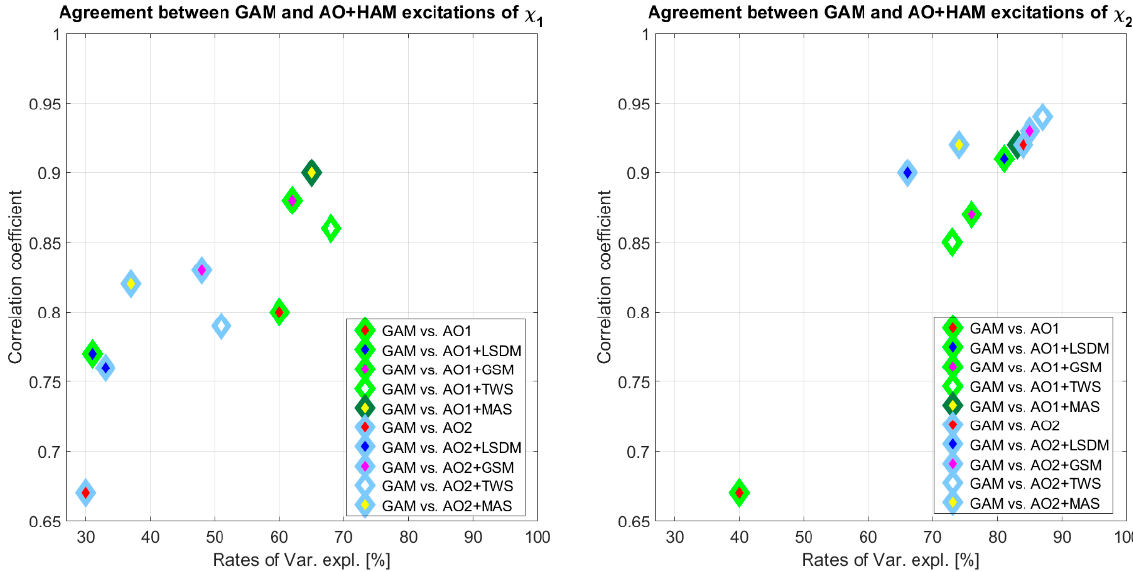
Figure 6. Correlation coefficients and variance explained rates between geodetic and geophysical interannual PM excitations improved by different HAM excitations, for χ 1 ( left panel ), and χ 2 ( right panel ).